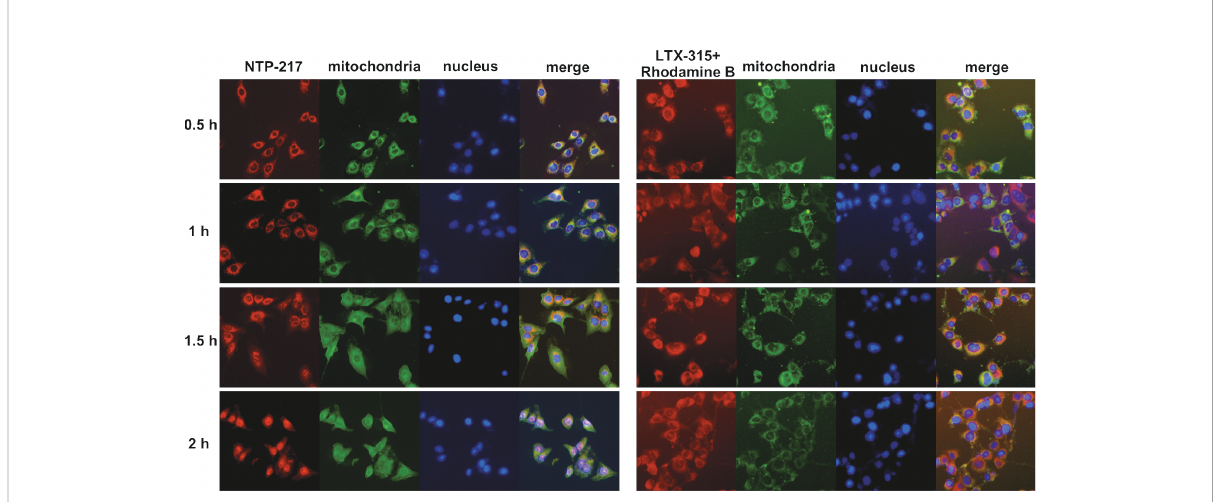
FIGURE 5 Induction of mitochondrial leakage by NTP-217. Fluorescent images of Hepa 1-6 cells incubated with 50 m M NTP-217 or 50 m M LTX-315 plus 50 m M rhodamine B for different lengths of time (objective magni fi cation, x20). Mitochondria were labeled with Mito-Tracker Green, while nuclei were stained with Hoechst